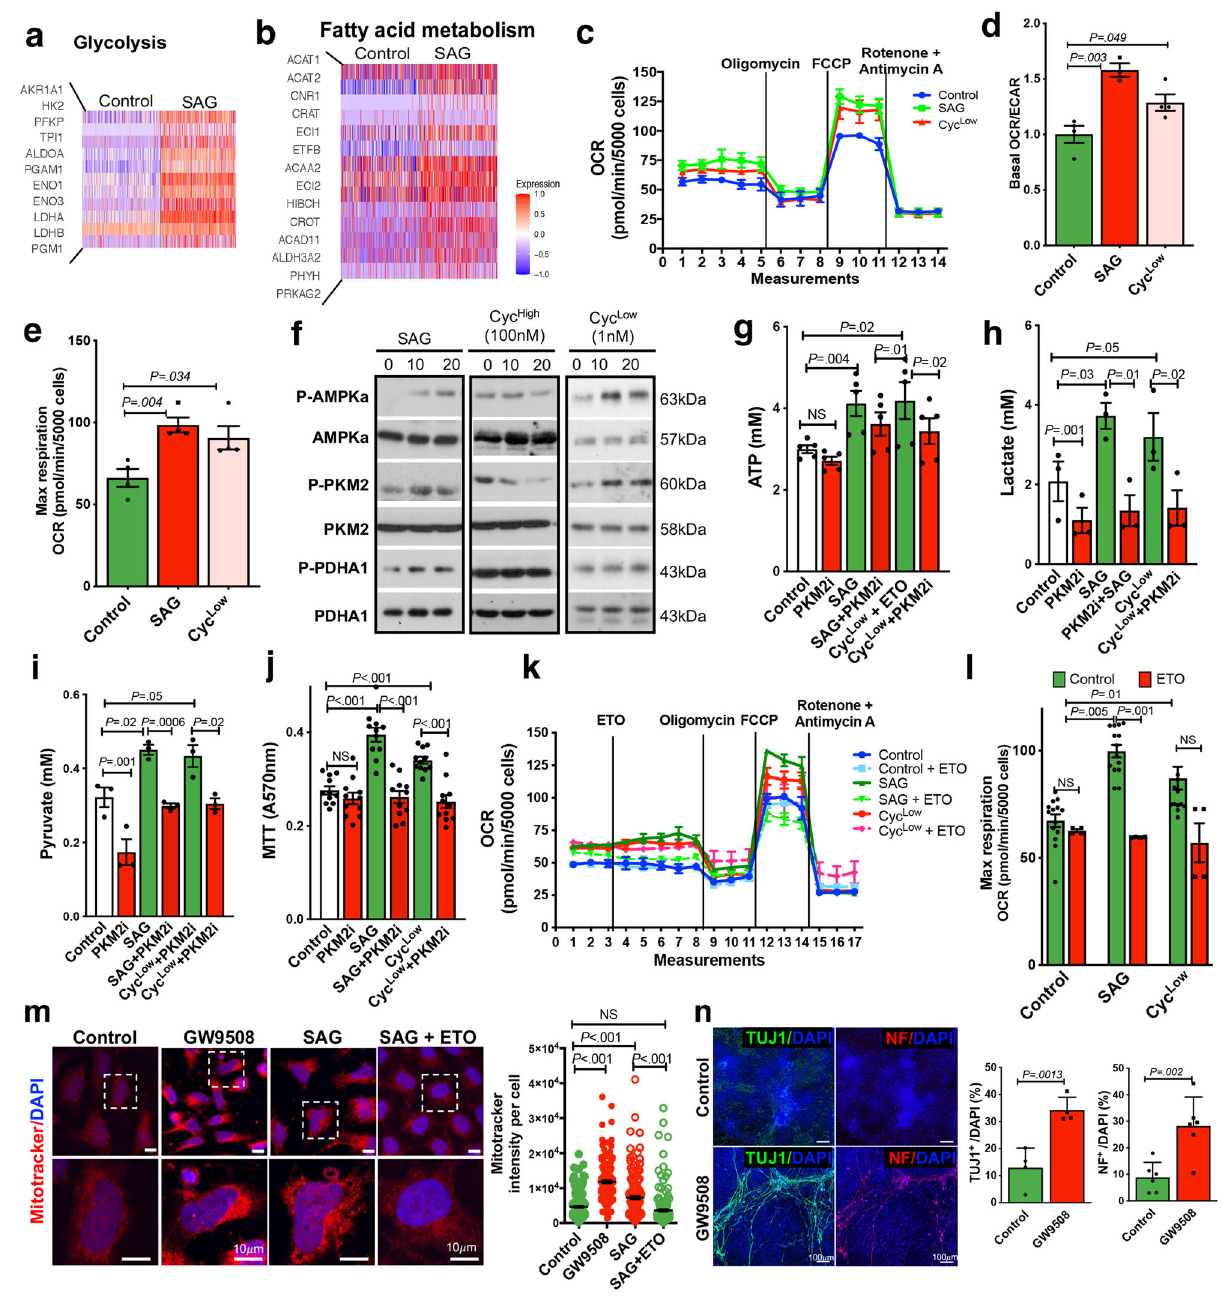
Fig. 6 | Hedgehog-induced metabolic shift in ENCCs. Heatmaps show genes implicatedin a glycolysisand b fattyacidmetabolismpathwaysinENCCsuponthe SAG treatment. c Seahorse assays of control-ENCCs treated with SAG or cyclopa- mine (1nM, Cyc Low ). (Mean±SEM, n =4). Dot plots from three independent experiments show the changes in d the basal oxygen consumption rate (OCR) to extracellular acidi fi cation rate (ECAR) ratios and e the maximum respiration rates upon different treatments (mean±SEM, n =4, Student ’ s t -test, two-sided). f Western blot shows the alternations of AMPK-PKM2-PDHA1 pathway in ENCCs subjected to SAG, cyclopamine (100nM, Cyc high and 1nM, Cyc Low ) treatments. Representative images from three independent analyses are shown. The samples were derived from the same experiment, and the gels/blots were processed in parallel.Barchartsshow g ATP( n =5), h lactate( n =3), i pyruvate( n =3),and j MTT